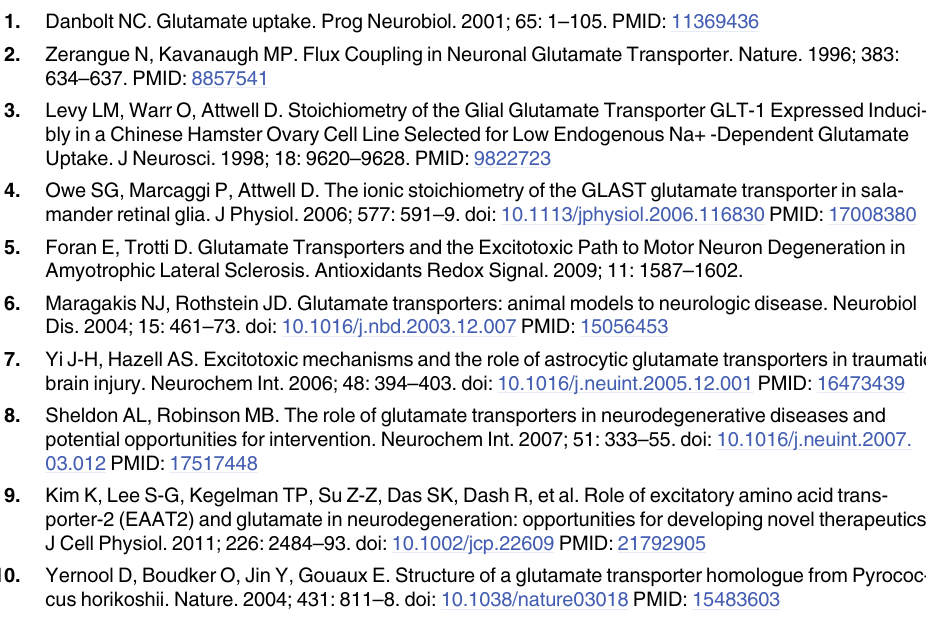
S7 Fig. RMSD to the intermediate state. The RMSD plot measures the structural deviation of each chain for three independent SMD simulations to the crystallographically observed inter- mediate state (PDB ID: 3V8G). Chain A is shown in black, chain B in red, chain C in blue. (TIFF) S8 Fig. Correlation analysis. Principal component analysis of three independent simulations (panels (a, b, c): chain A, B, C of simulation 1; panels (d, e, f): chain A, B, C of simulation 2; panels (g, h, i): chain A, B, C of simulation 3); the figures are as depicted in the main manu- script (Fig 8). Briefly, movement of a GltPh protomer along the two largest eigenvectors (trans- lation, rotation of the domains relative to each other) observed in the simulations. Each dot represents the projection of one frame in the trajectory onto the 2 dimensions of eigenvectors 1 and 2. Four distinct periods of the trajectory are color coded: The first part of the trajectory (red) represents the outward-occluded state before rotation of the T308 side chain. A shift to orange marked the rotation of T308. Rotation of the side chain of Y195 marks the transition to the third period (pink). The fourth region shown in blue represents the period after opening of the intracellular interaction network. The intermediate state is reached in the populated region in the middle of the plot, after opening of the intracellular interaction network.